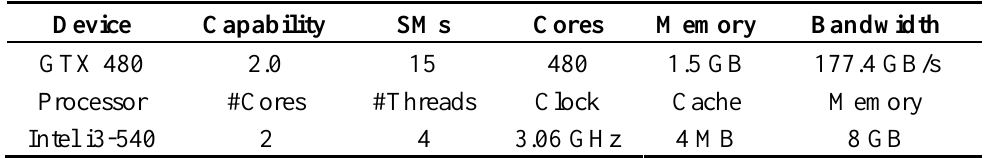
1. GPU device and multi-core processor specifications. SM, streaming